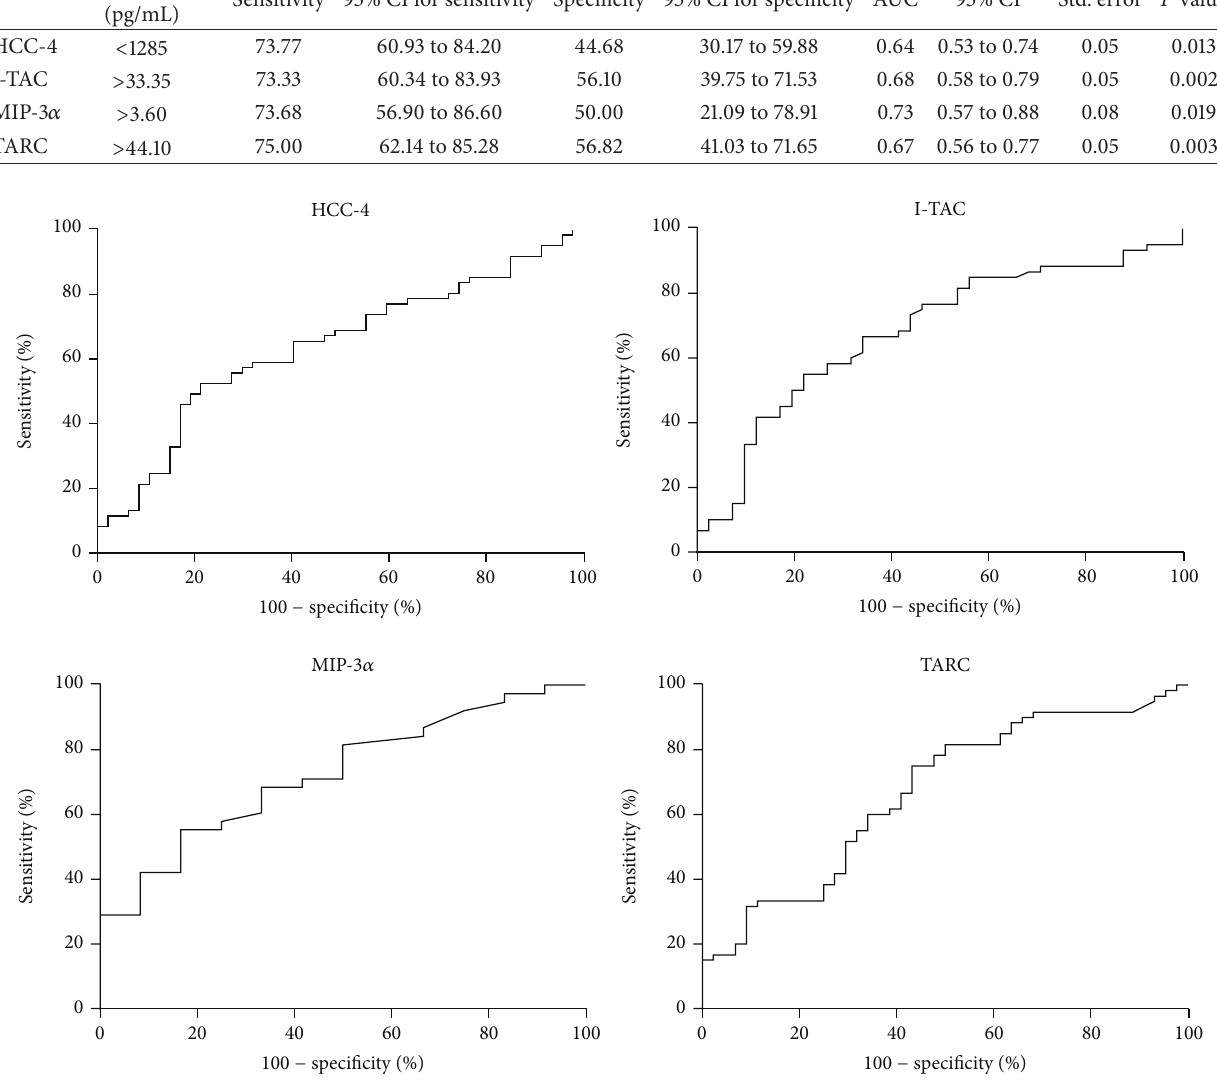
Figure 1: The ROC curves for concentration of chemokines HCC-4, I-TAC, MIP-3 𝛼 , and